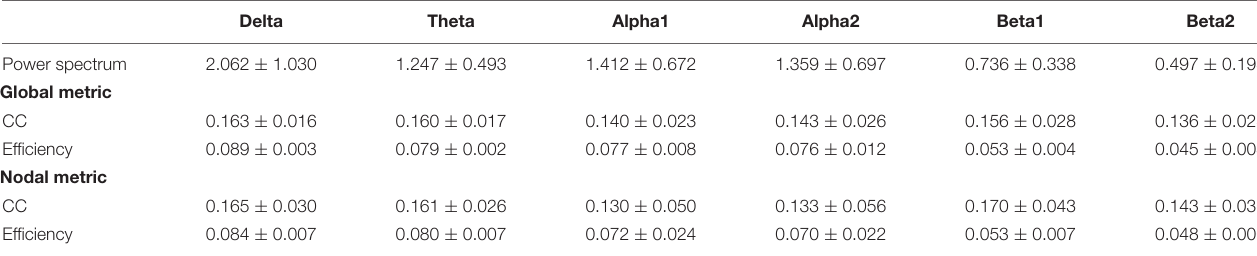
TABLE 1 | Descriptive results of electroencephalography (EEG)